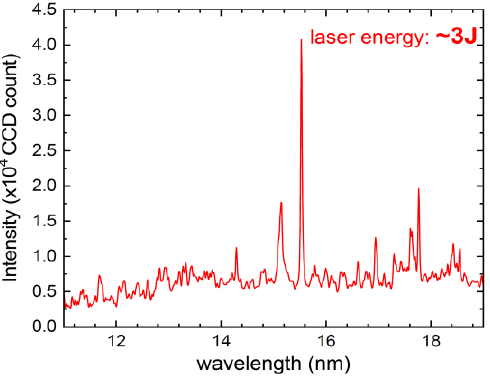
Figure 3. Lasing spectrum of 15.5 nm Li-like Al ion 3 d -4 f trainstion.